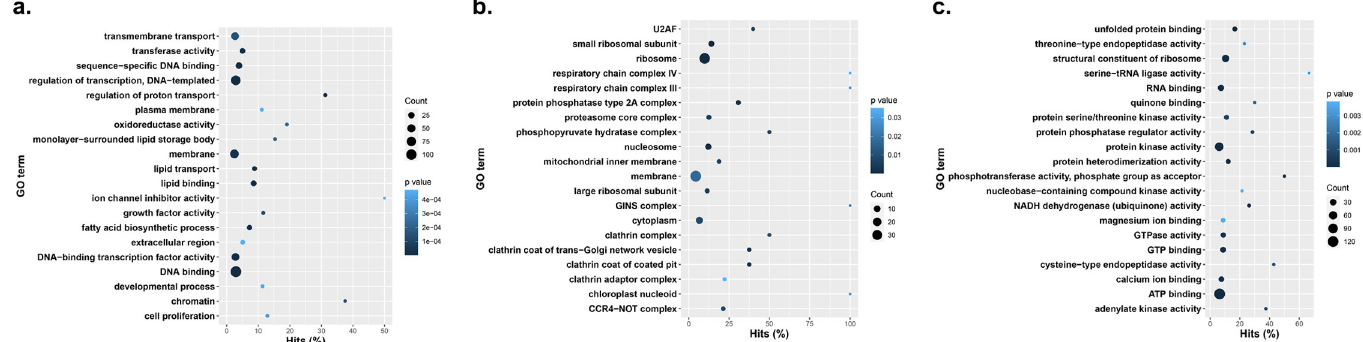
Fig 3. Gene ontology enrichment terms and their prevalence among GS A . palmeri eccDNA samples. A. Biological processes, B. cellular components, C. molecular functions.